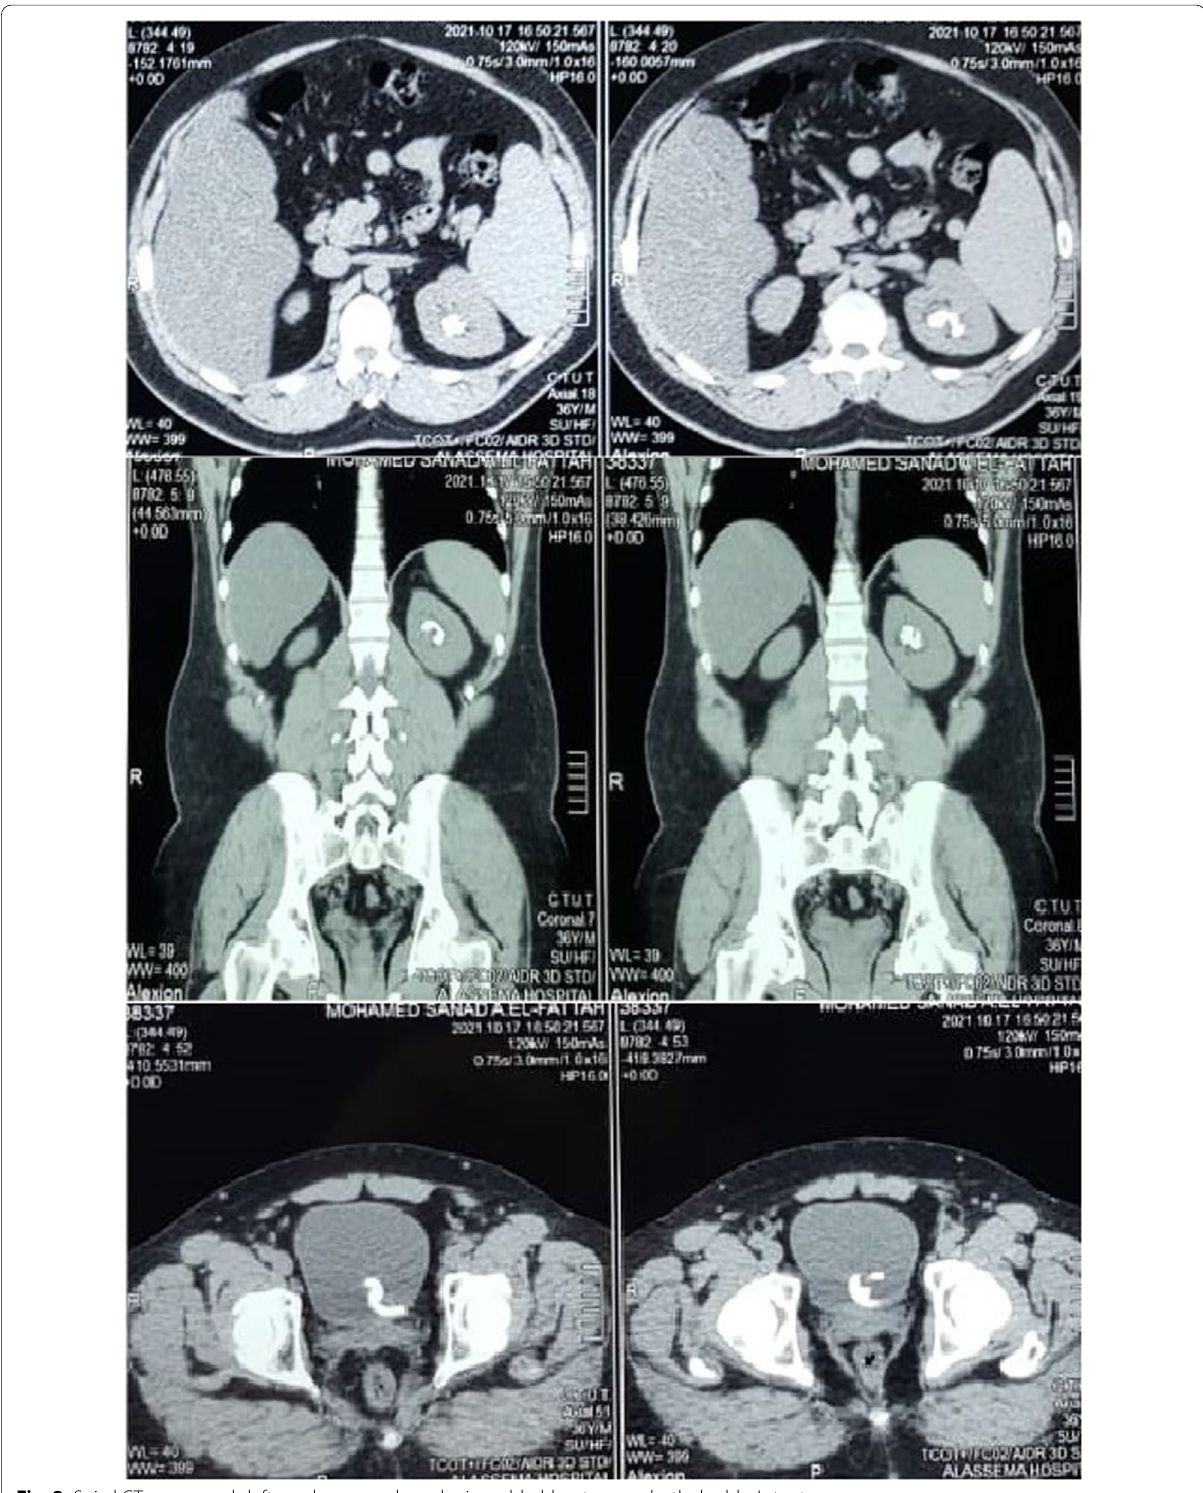
Fig. 2 Spiral CT scan reveals left renal upper pole and urinary bladder stone on both double J